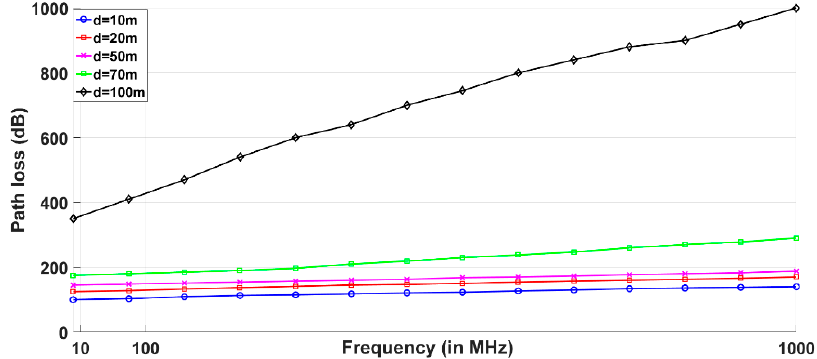
Figure 11. Path loss in electromagnetic tracking at different operational frequencies and distance between the diver and electromagnetic transmitter.